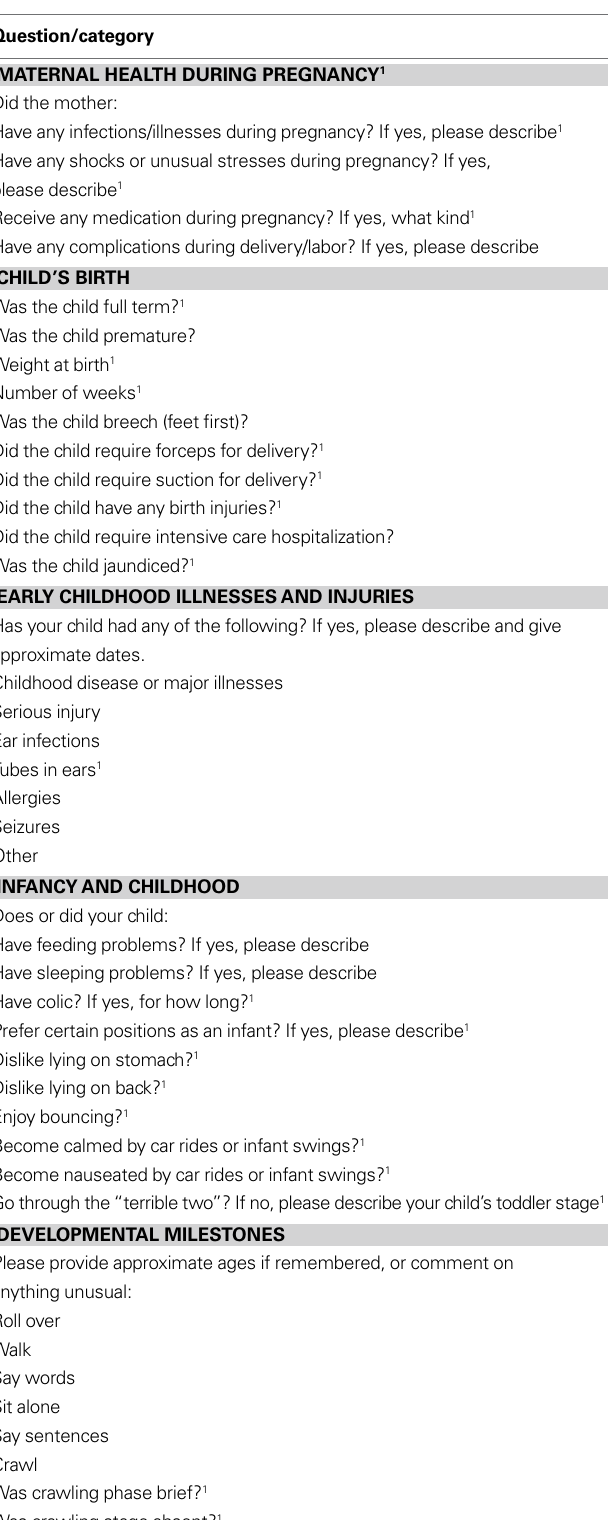
Table 2 | Developmental Sensory History